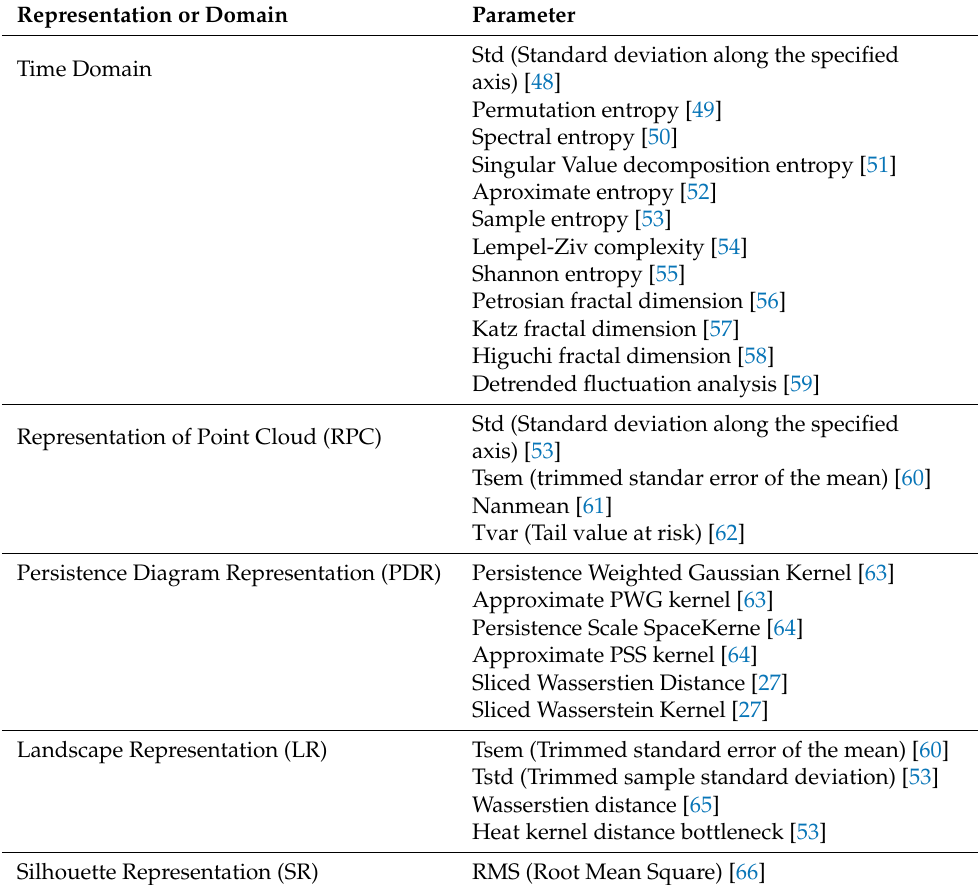
Table 3. List of extracted features using TDA and other time-domain parameters used as an input vector to the